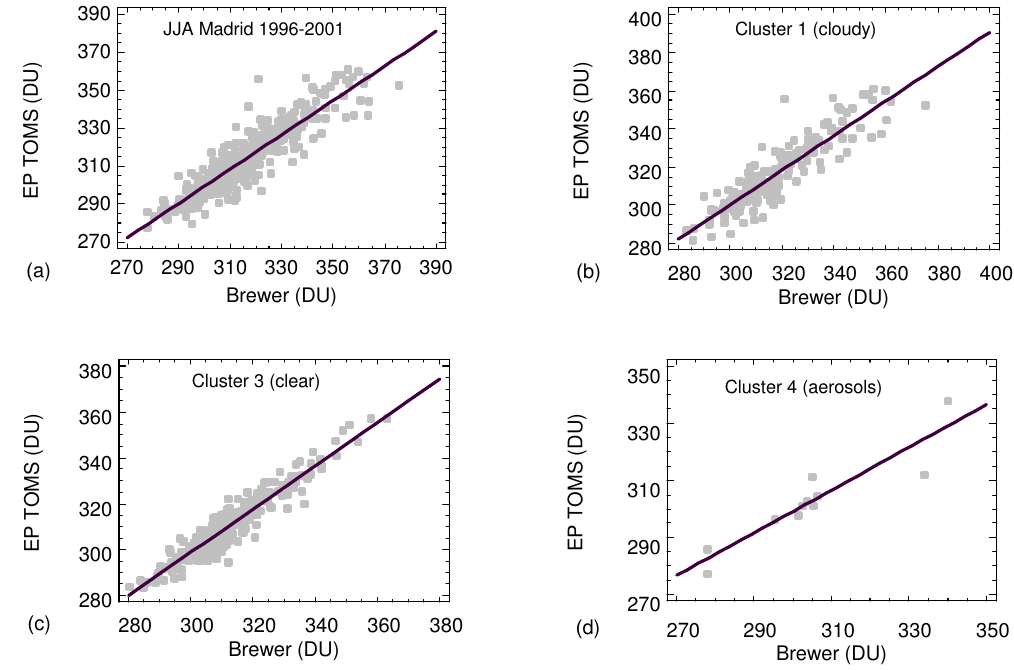
Fig. 3. Scattergram for linear correlations between EP-TOMS and Brewer total ozone in column data from Madrid 1996–2001 June-July- August datasets. (a) all data pairs, (b) cluster 1 (cloudy), (c) cluster 3 (clear), (d) cluster 4 (aerosols).